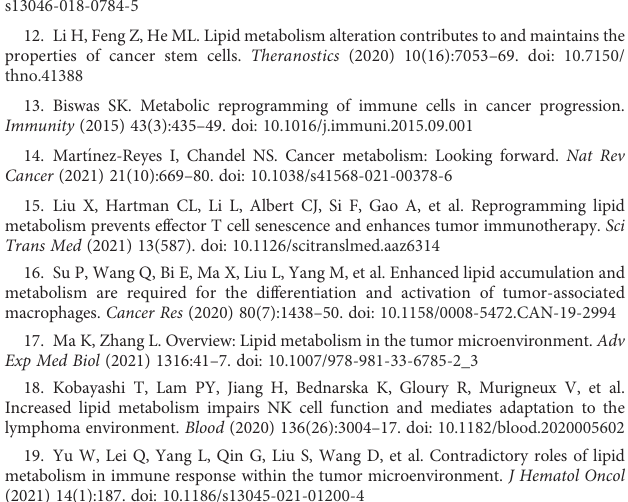
SUPPLEMENTARY TABLE 3 DEGs between gliomas and normal brains in TCGA cohort. DEG, different expression gene; TCGA, The cancer Genome